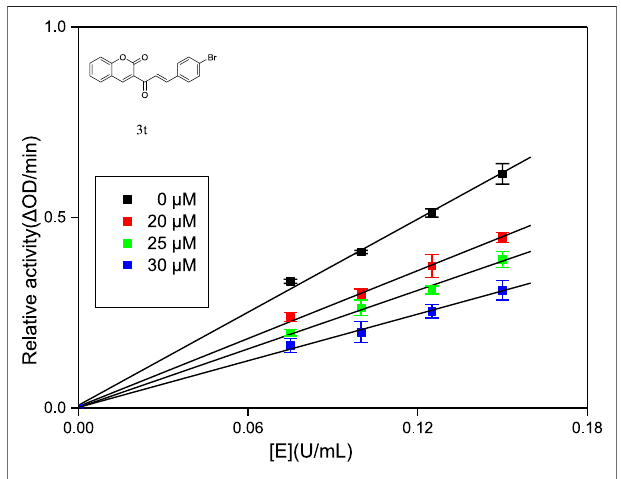
FIGURE 2 | Inhibition mechanism determination of compounds 3t on α - glucosidase.